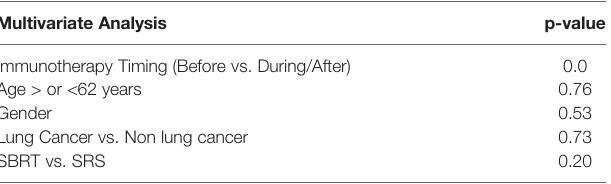
TABLE 3 | Multivariate analysis results showing that immunotherapy timing remained signi fi cant when accounting for age, sex, type of cancer (lung vs. other), and type of radiation treatment.